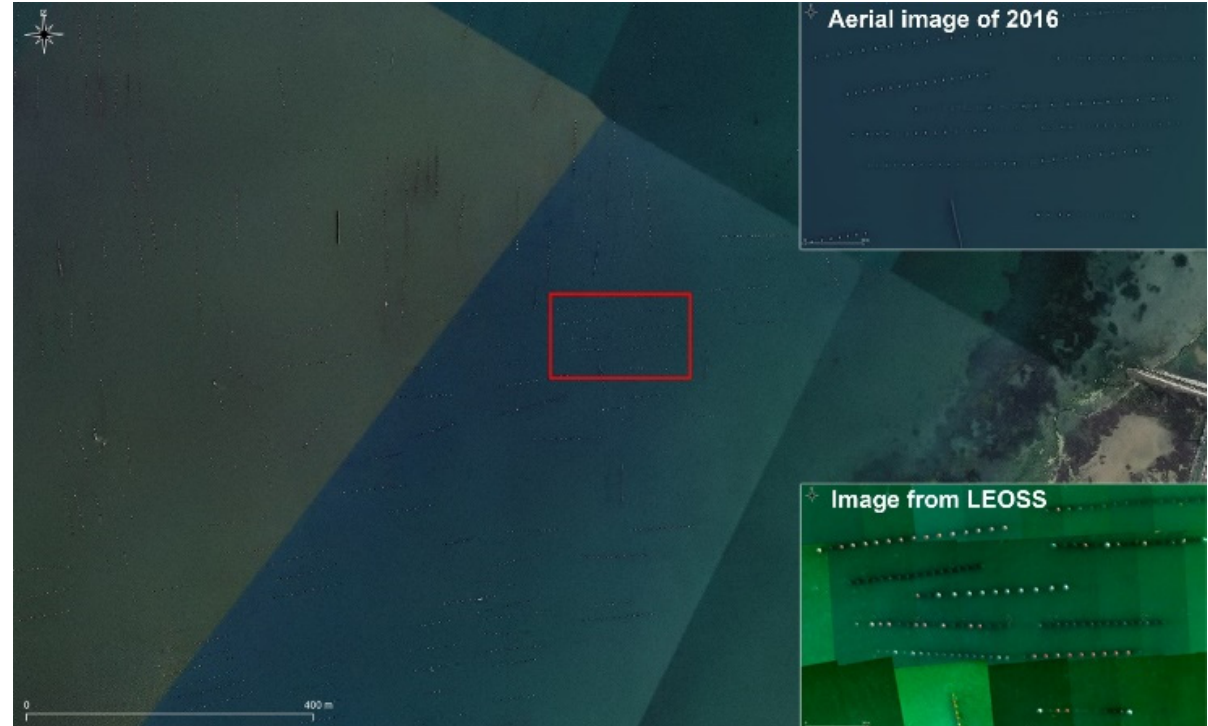
Figure 13. Example of disorder due to overexploitation.